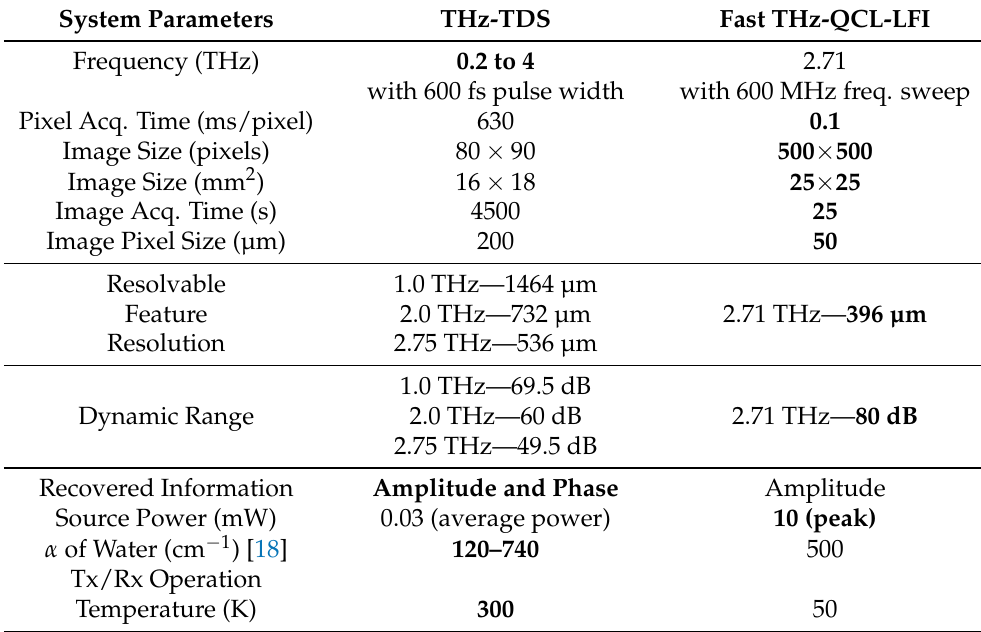
Table 1. Various parameters of the imaging systems used for hydration